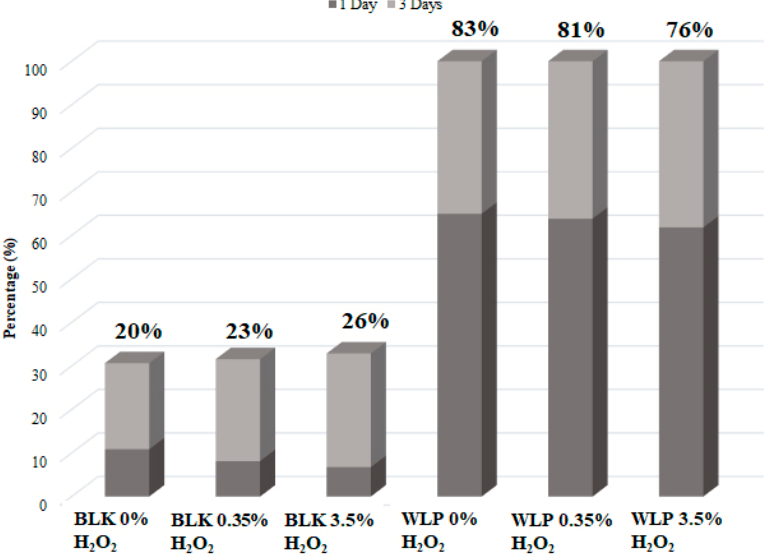
Figure 2. Comparative graph of PAHs removal in all tested conditions: BLK 0% of H 2 O 2 , BLK 0.35% of H 2 O 2 , BLK 3.5% of H 2 O 2 , WLP 0% of H 2 O 2 , WLP 0.35% of H 2 O 2 , and WLP 3.5% of H 2 O 2 .